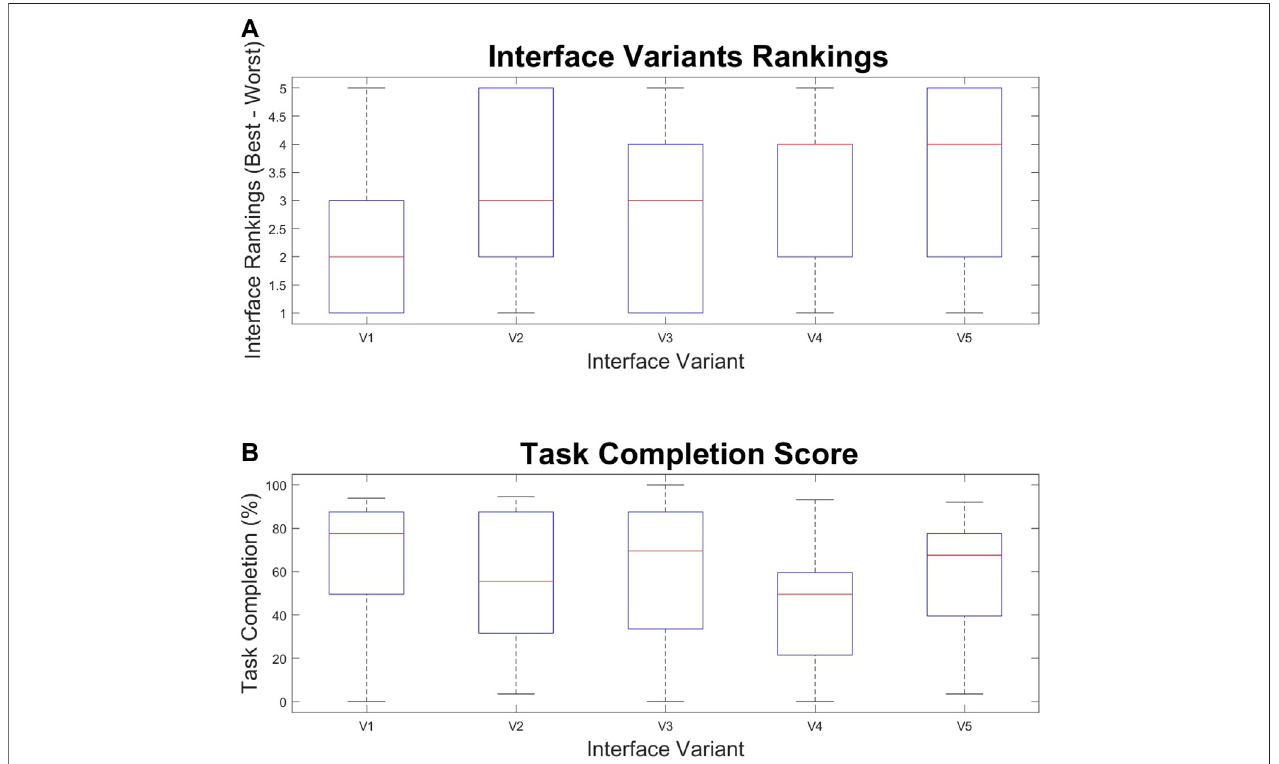
FIGURE 7 | Box and whisker graphs showing (A) User rankings of each interface (1 is best, 5 is worst) and (B) Task completion percentage over the Interface Variants (V1 – V5).